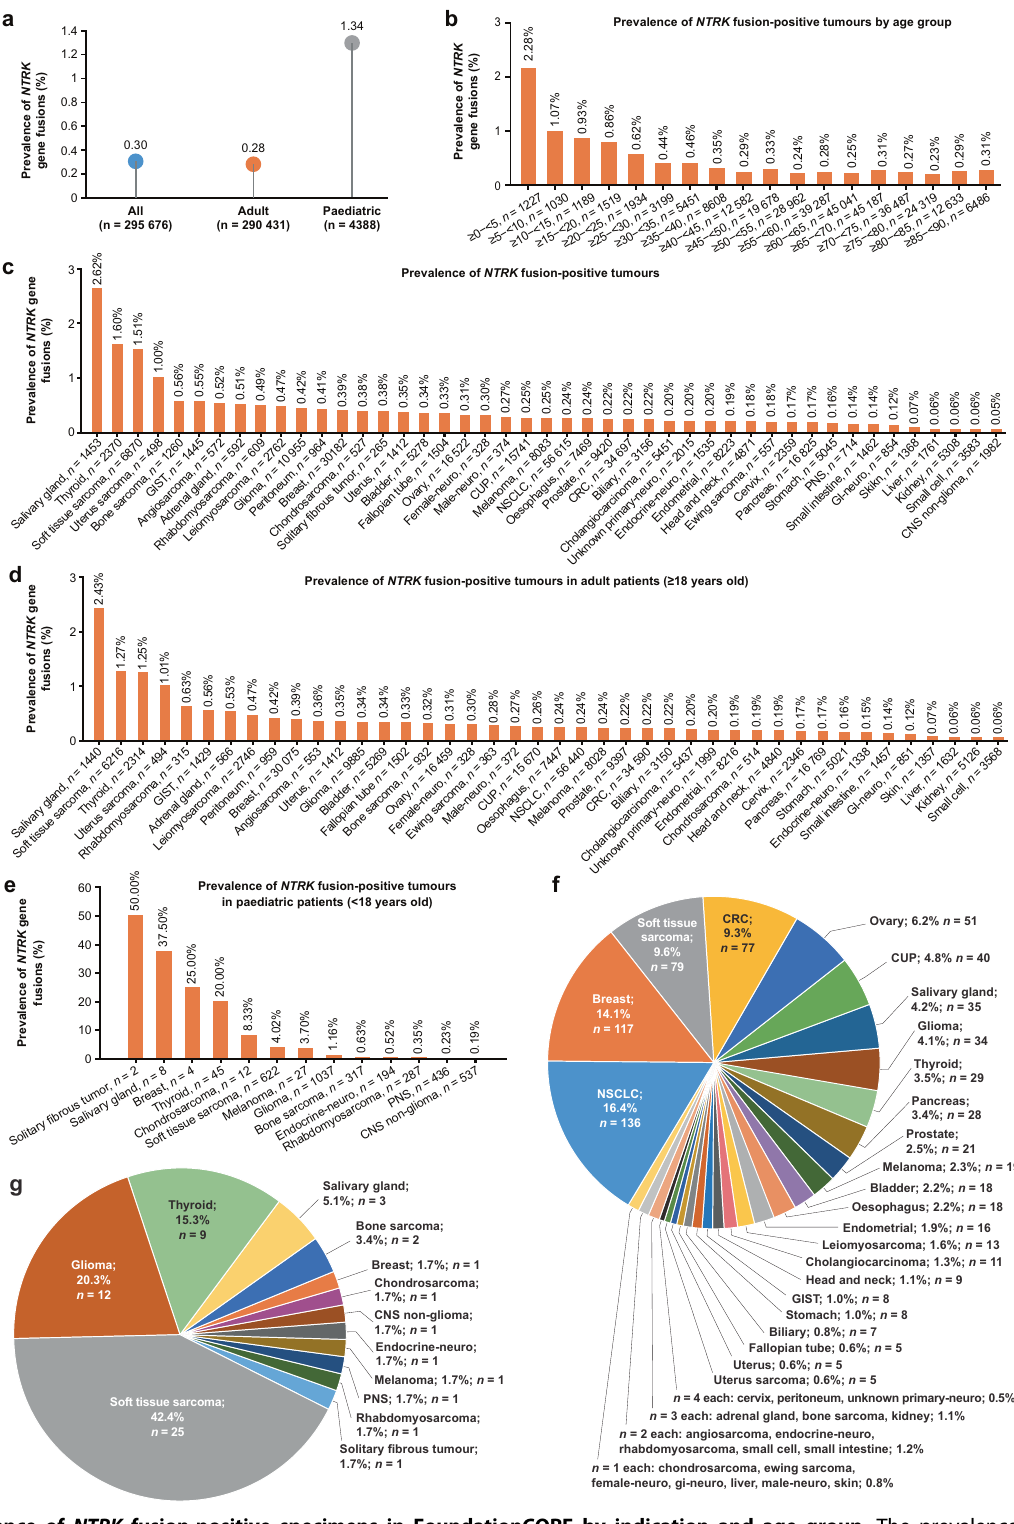
Fig. 1 Prevalence of NTRK fusion-positive specimens in FoundationCORE by indication and age group. The prevalence of NTRK gene fusions overall and among adult (aged ≥ 18 years) and paediatric patients (aged <18 years; ( a ). The prevalence of NTRK gene fusions by age group ( b ). The prevalence of NTRK gene fusions by cancer type among: all patients ( c ), adult patients ( d ) and paediatric patients ( e ), with n numbers representing the total number of patients analysed per tumour type. Prevalence analysis of cancer types among all NTRK fusion- positive tumours in adults ( f ) and paediatric patients ( g ), where numbers represent the total number of patients with each cancer type. CNS central nervous system, CRC colorectal carcinoma, CUP unknown primary carcinoma, GI gastrointestinal, GIST gastrointestinal stromal tumour, NSCLC non-small cell lung cancer, NTRK neurotrophic tyrosine receptor kinase, PNS peripheral nervous